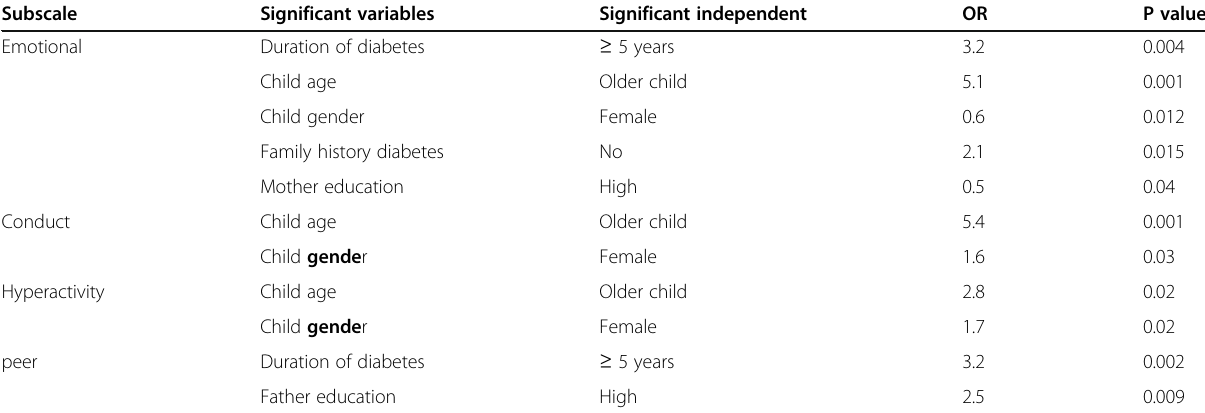
Table 3 Determinants of abnormal SDQ Subscales by logistic regression Subscale Significant variables